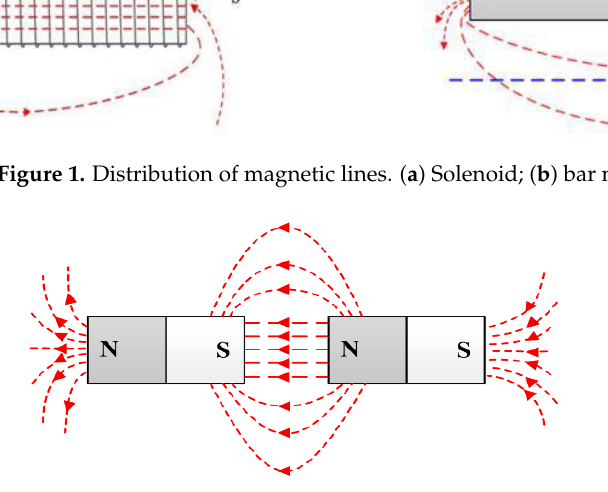
Figure 2. The distribution of magnetic lines when the different magnetic poles of two bar magnets approach each other.